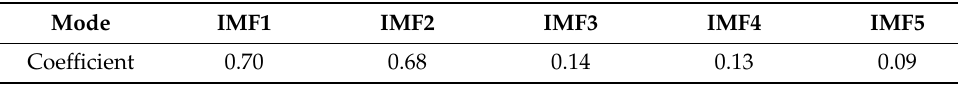
Table 1. Coefficients under EMD decomposition.